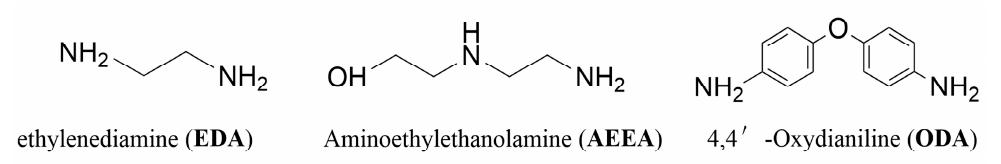
Figure 1. Chemical structures of amine chain